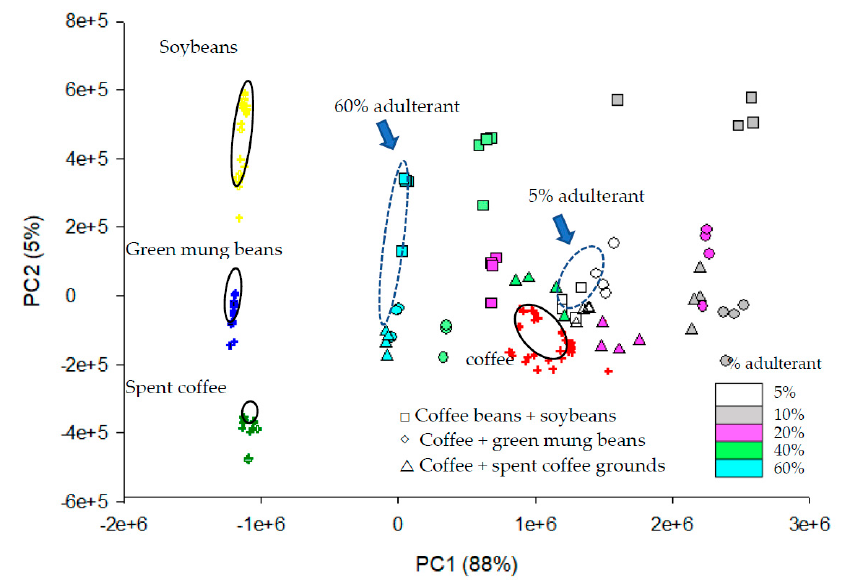
Figure 3. PCA-scores scatter plot of coffee beans in comparison to soybeans, green mung beans, spent coffee grounds and adulterated coffee containing different adulterants in different mixing ratios (5%, 10%, 20%, 40% and 60%).